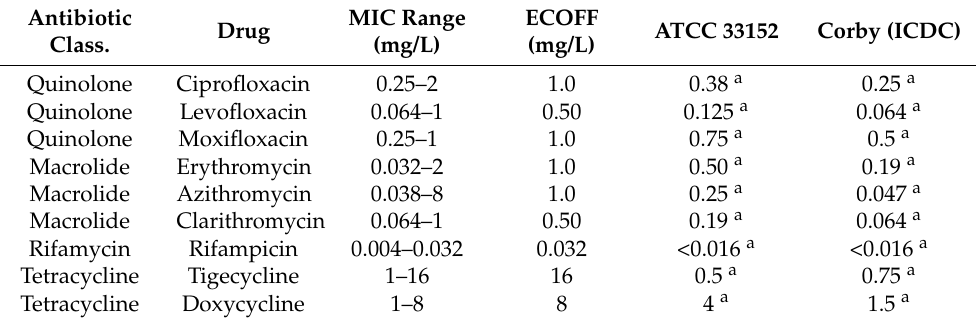
Table 1. MIC values of antibiotics for the Legionella pneumophila Corby (ICDC) clinical isolate. Antibiotic